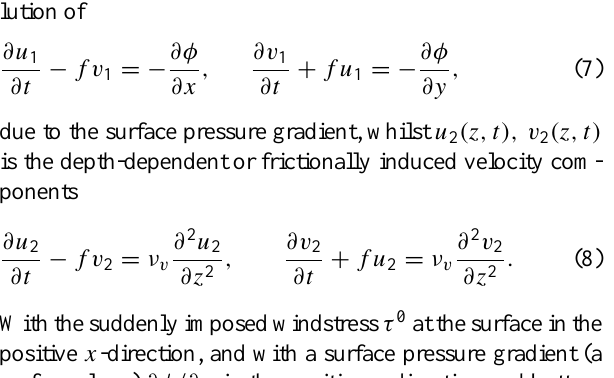
Fig. 4. Hodographs of the horizontal velocity vectors in the middle of the rectangular basin in 0, 5, 10, 20 and 60 m depths (a) . In order to see more clearly the spiral at 20 m depth, the 20 m hodograph is shown separately in (b) . The motion starts from a state at rest. The small circles mark time intervals of 1/4 inertial period.